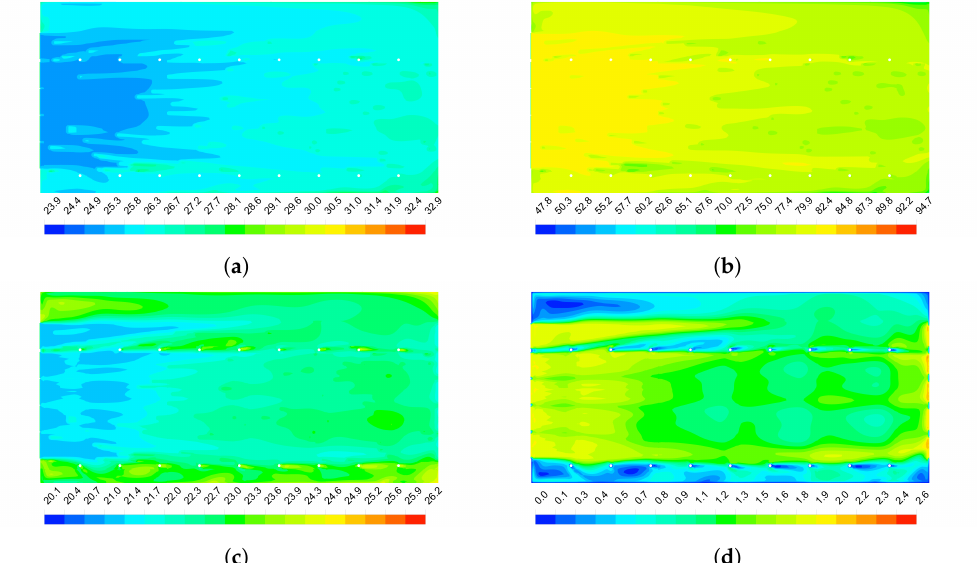
Figure 10. Distribution of the air thermal variables analysed inside the tunnel-ventilated compost- packed bedded dairy barn 1.6 m above the floor. ( a )—Dry-bulb temperature ( ◦ C). ( b )—Relative humidity (%). ( c )—Equivalent Temperature Index for dairy Cattle (ETIC, ◦ C). ( d )—Air velocity (m s − 1 ). The airflow direction is from left to